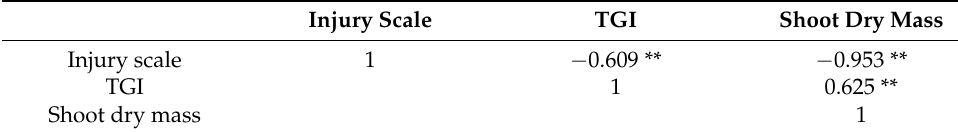
Table 2. Pearson’s correlation (r) between the variables studied. Injury Scale TGI Shoot Dry Mass Injury scale 1 − 0.609 ** − 0.953 ** TGI 1 0.625 ** Shoot dry mass 1 Injury scale: Soybean injury visible evaluations [29] at 45 days after sowing. Triangular greenness index (TGI) at 45 days after sowing. Shoot dry mass: Soybean dry shoot mass (g) at 99 days after soybean sowing. **: Significant differences at 0.01.